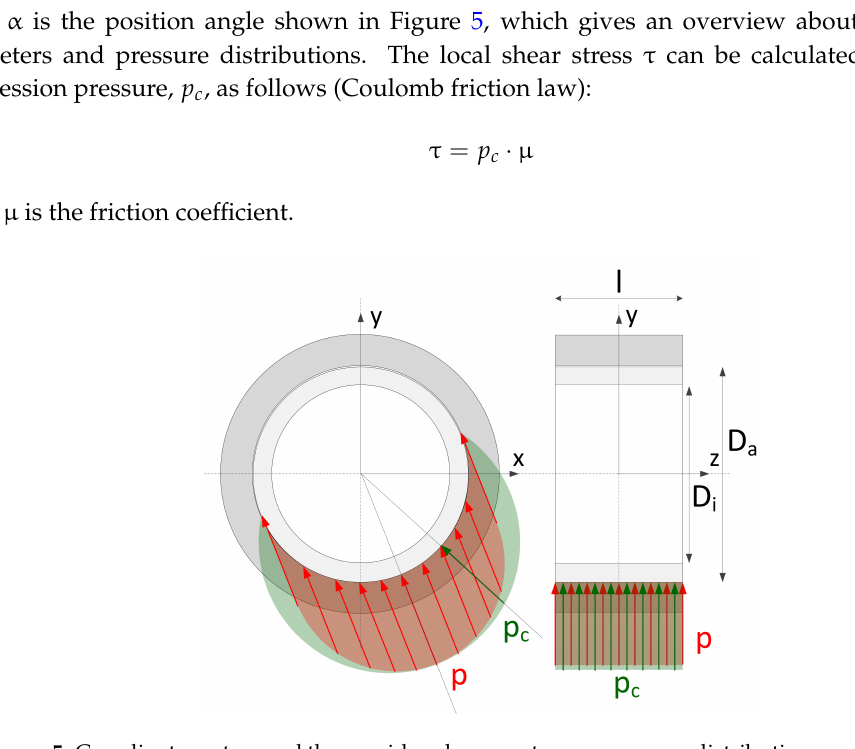
Figure 5. Coordinate system and the considered parameters: p : pressure distribution; p c : compression pressure; l : length/width bearing; D i : inner diameter bearing; D a : bearing diameter; α : position